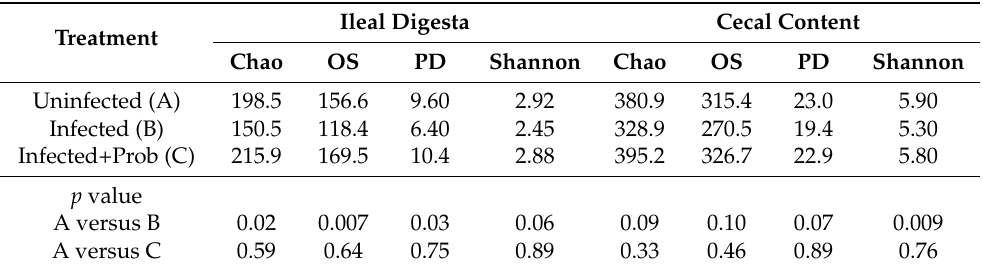
Table 3. Diversity of the intestinal microbiota of broilers challenged with an experimental model to reproduce NE and supplemented with Bacillus subtilis DSM